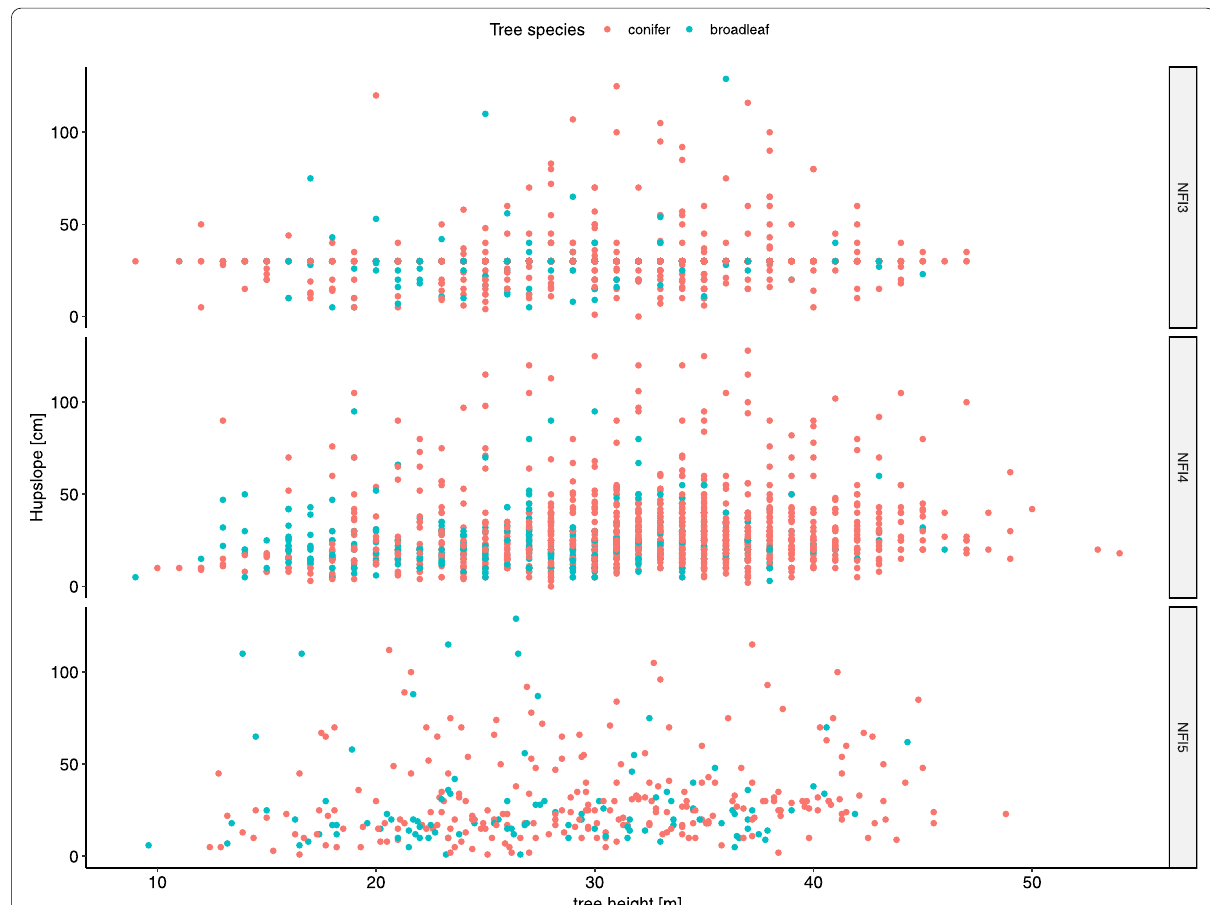
Fig. 8 Stump height and tree height for stumps for which the tree height was measured in the previous NFI (NFI3, 1406 stumps; NFI4, 1420; NFI5, 351). Stump height in the NFI3 and NFI4 was measured on the upslope facing side; in the NFI5, heights were measured on the upslope and downslope facing